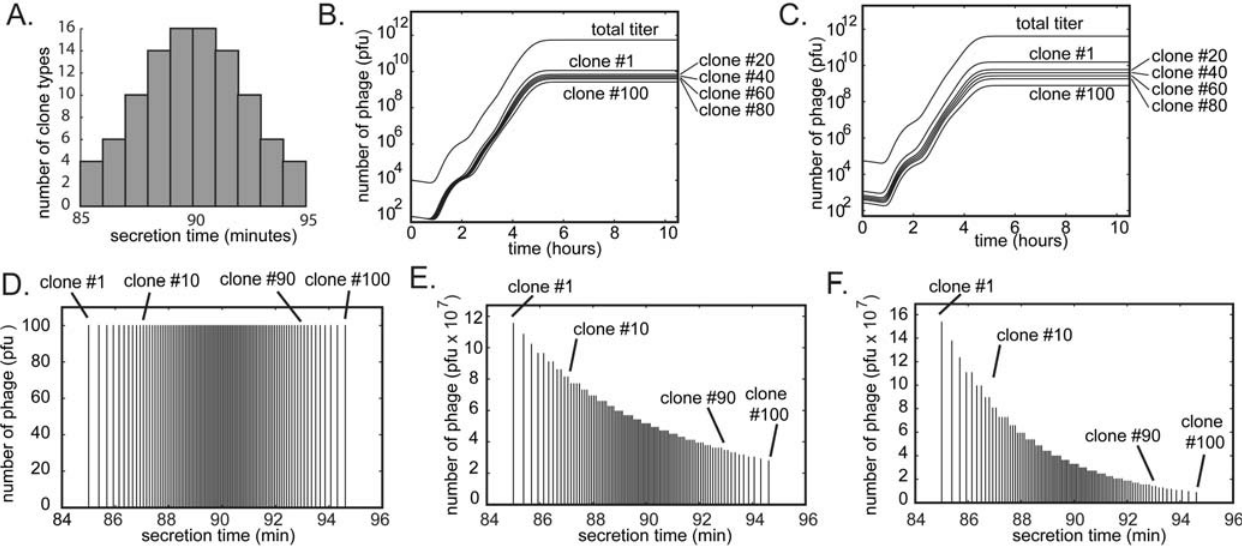
Figure 7. A simulation of the growth of a library containing 100 different clones. ( A and D ) The initial population contains equal concentrations of the clones (numbered #1 through #100). The clones differ only in the time they are produced by the bacteria (average burst time is slowest for #1 and fastest for #100). We approximate the burst time of different clones in the population to follow a Gaussian distribution ( i.e. , the abundance of the fast and slow growers is low; most clones have an average growth rate). ( B ) Amplification of mixture of 100 copies of each clone using 10 8 bacteria (see Figures 6D-G for details of the amplification). In amplification from 10 4 pfu/mL to 10 12 pfu/mL, the ratio of clone #1 (fastest) to clone #100 (slowest) reaches 5:1 ( E ). ( C ) Dilution of the amplification result from B to ~10 4 and re-amplification to 10 12 further skews the distribution of the clones ( F